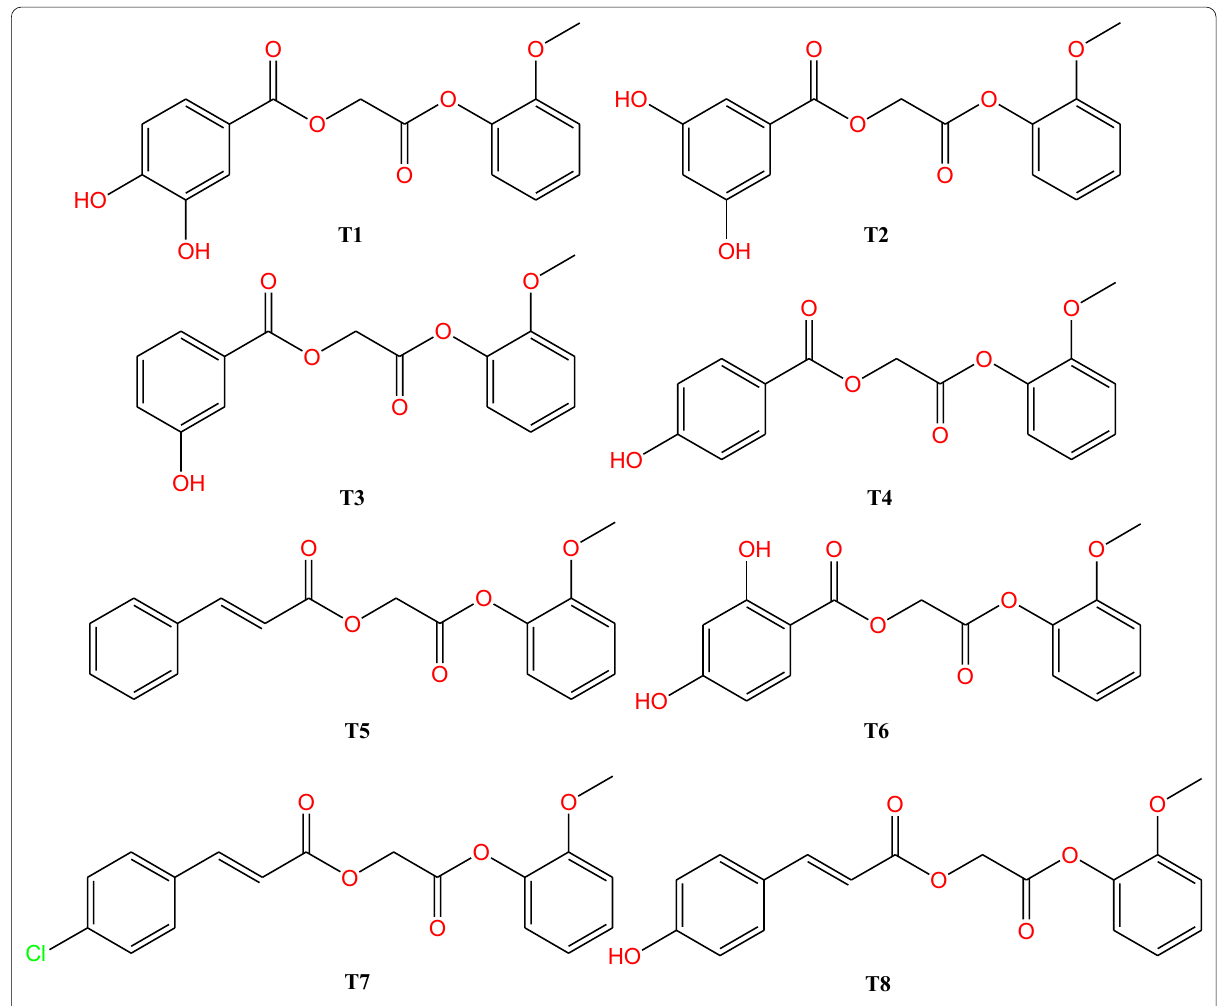
Fig. 1 Structures of synthetic phenolic derivatives (methoxyphenol derivatives) from T1 to